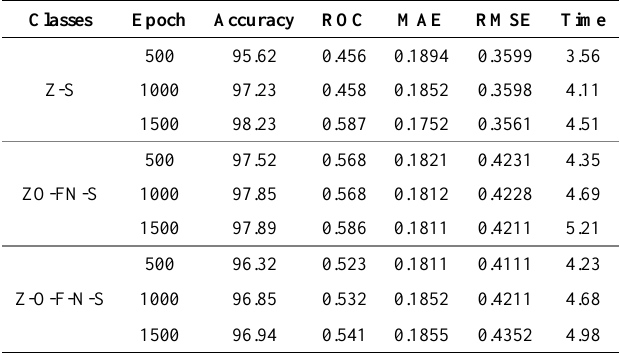
Table 3. Results of proposed method for different epochs